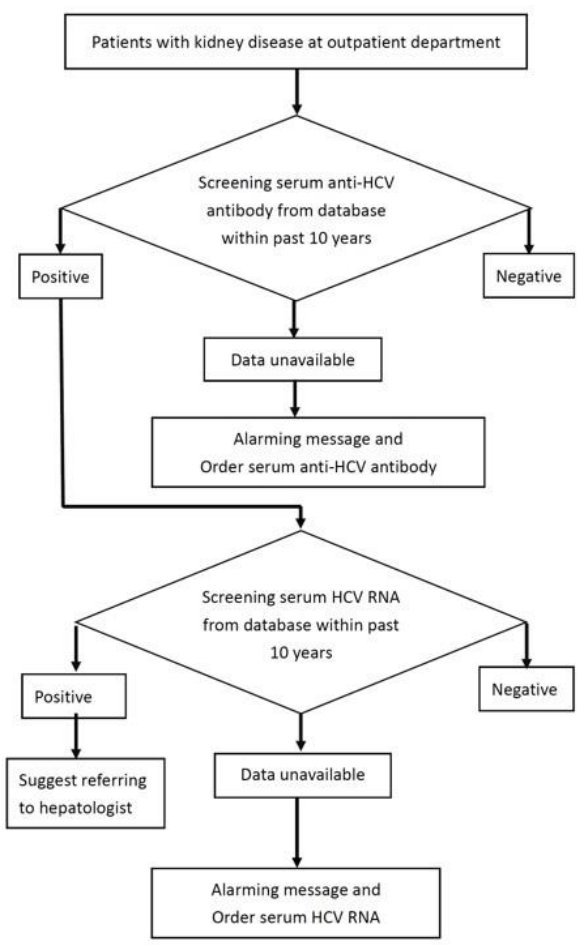
Figure 1. HCV screening flowchart targeting patients with kidney disease.